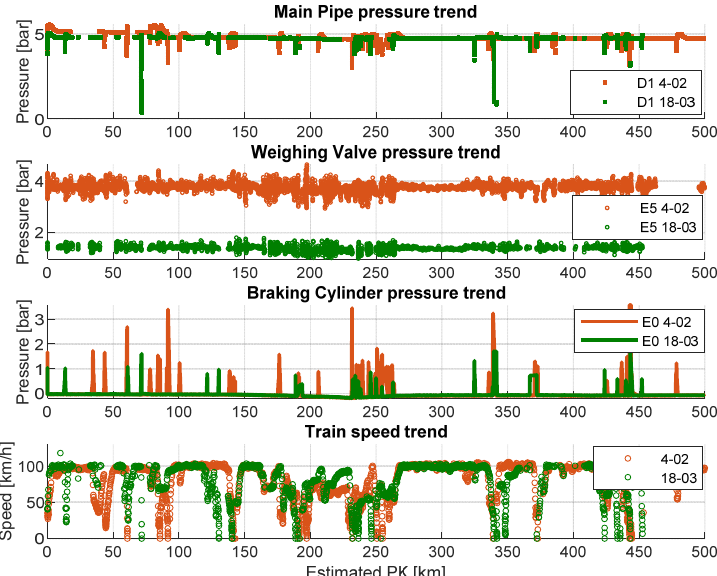
Figure 18. Comparison of braking events measures on different brake system points during two- wagon travel. Red lines refer to 4 February’s journey (loaded wagon), and green lines refer to 18 March’s journey (non-loaded wagon).